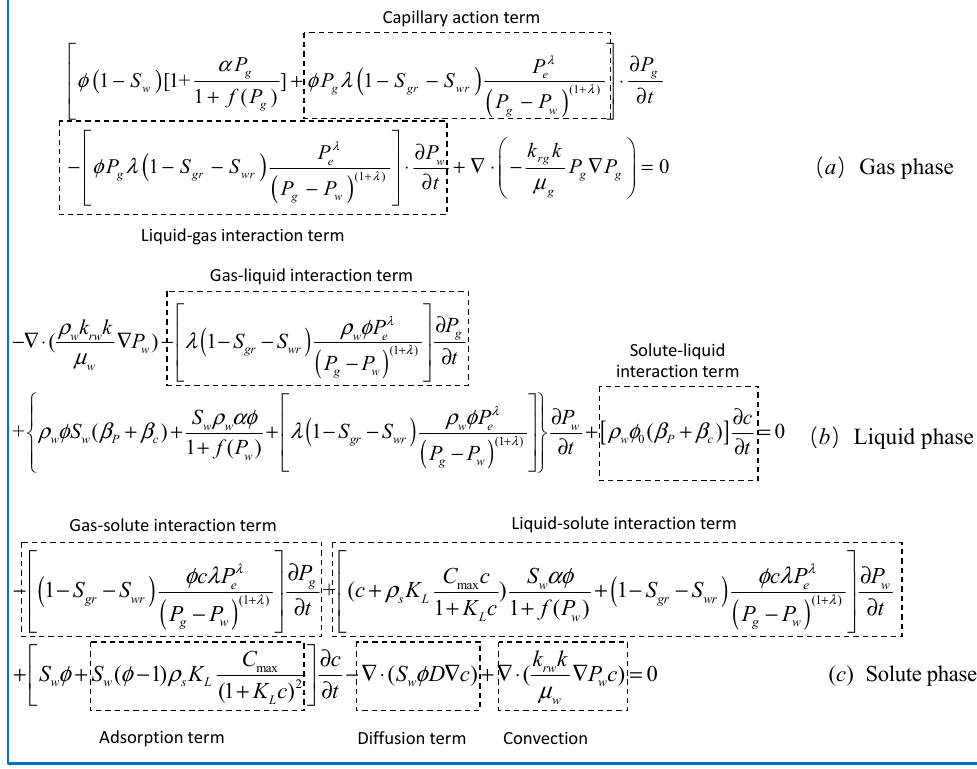
Figure 3. Water–gas–chloride coupling transport model in unsaturated concrete.